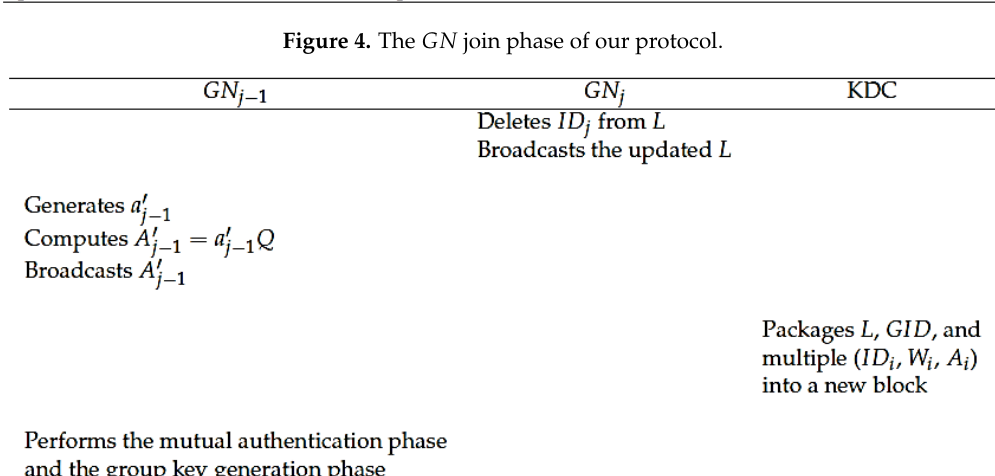
Figure 5. The GN leave phase of our